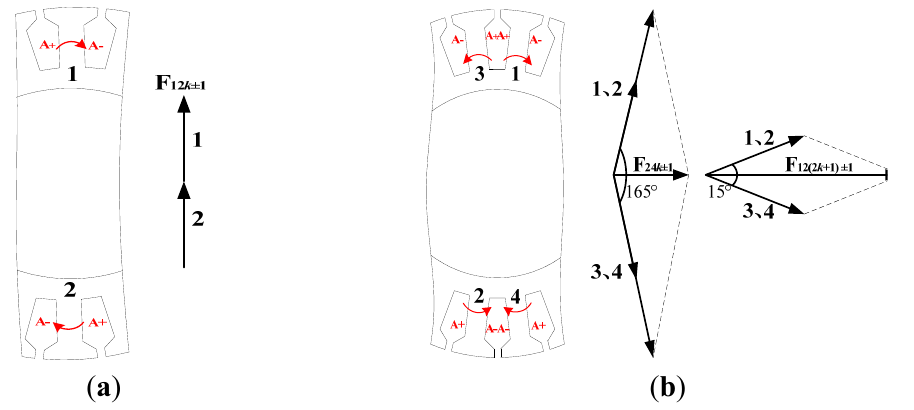
Figure 4. MMF vector composition of phase A winding: ( a ) Alternate teeth wound scheme; ( b ) All teeth wound scheme.